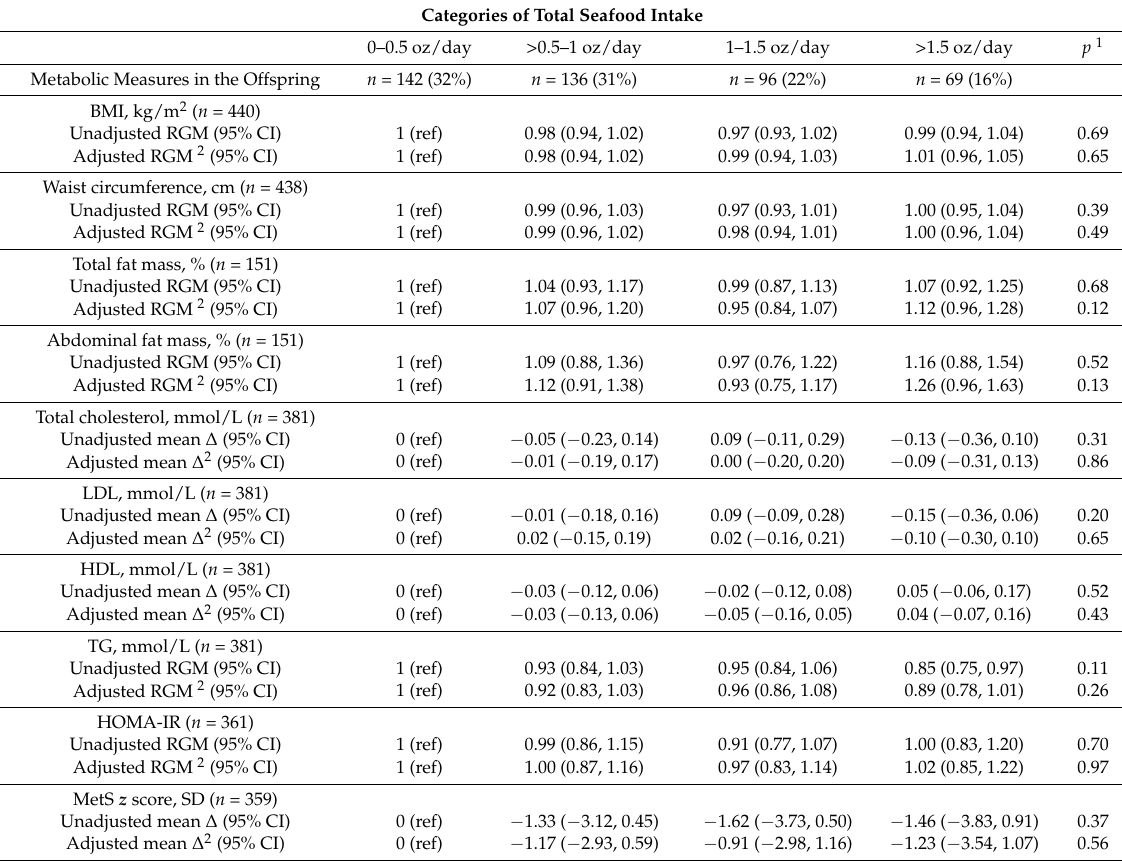
Table 2. The association between total seafood intake in gestational week 25 and offspring metabolic parameters at age 9–16 years in GDM-exposed mother-offspring